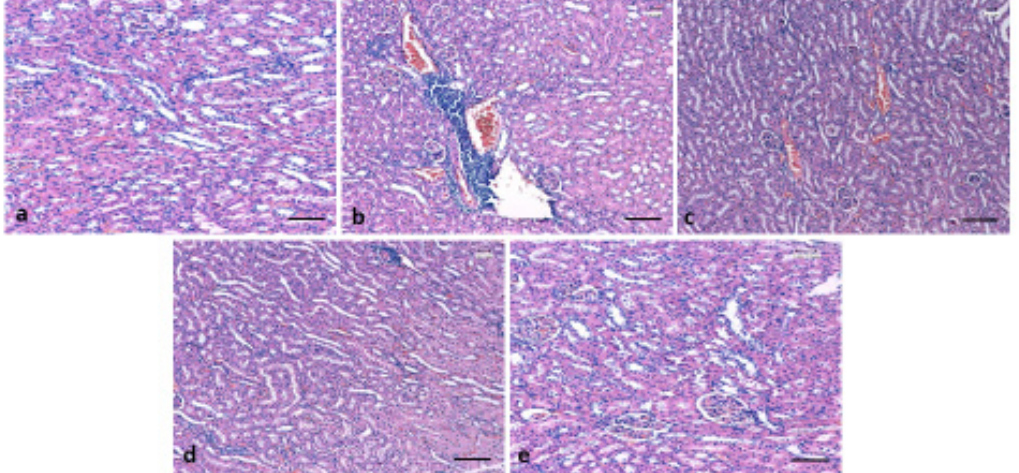
Figure 6. Effect of gingerol in histopathological changes of kidney tissues. ( a ): Typical architecture of kidney in control animals. ( b ): STZ only treated kidney tissues showed infiltration of lymphocytes, thickened glomerular basement membranes and congestion. ( c ): Administration of 6-gingerol markedly mitigated the irregularities in the glomerular and tubular architecture and displayed mild congestion, ( d ): positive control (diabetic rats treated with glibenclamide) showing normal architecture ( e ): Animal group treated with gingerol only showed normal architecture of kidney. (Scale bar = 100 µ m).